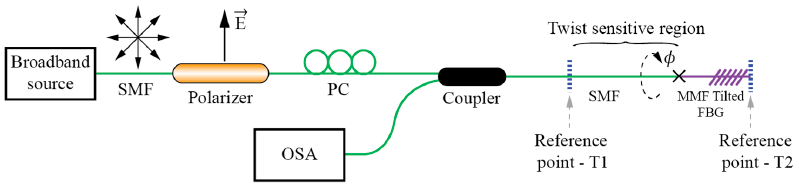
Figure 24. TFBG setup for twist/rotation measurements employing FBG’s inscribed in multi-mode fiber.